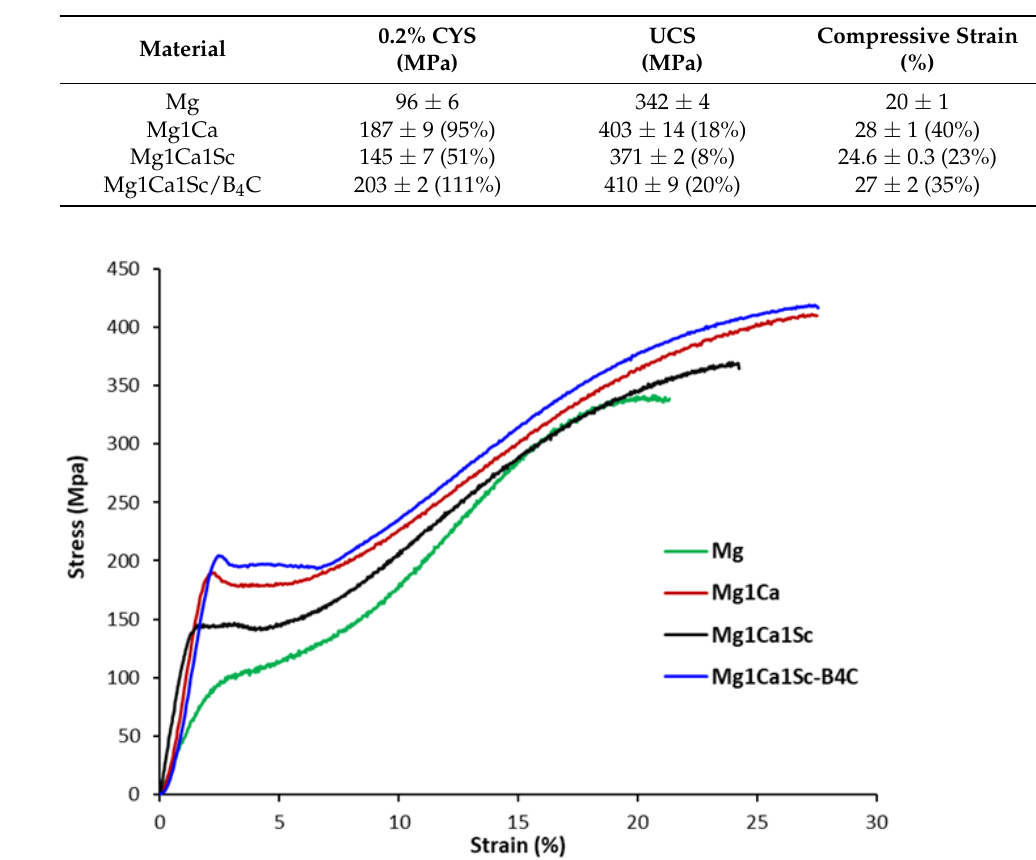
Figure 6. Compressive deformation curves of Mg, Mg alloys and the Mg nanocomposite.